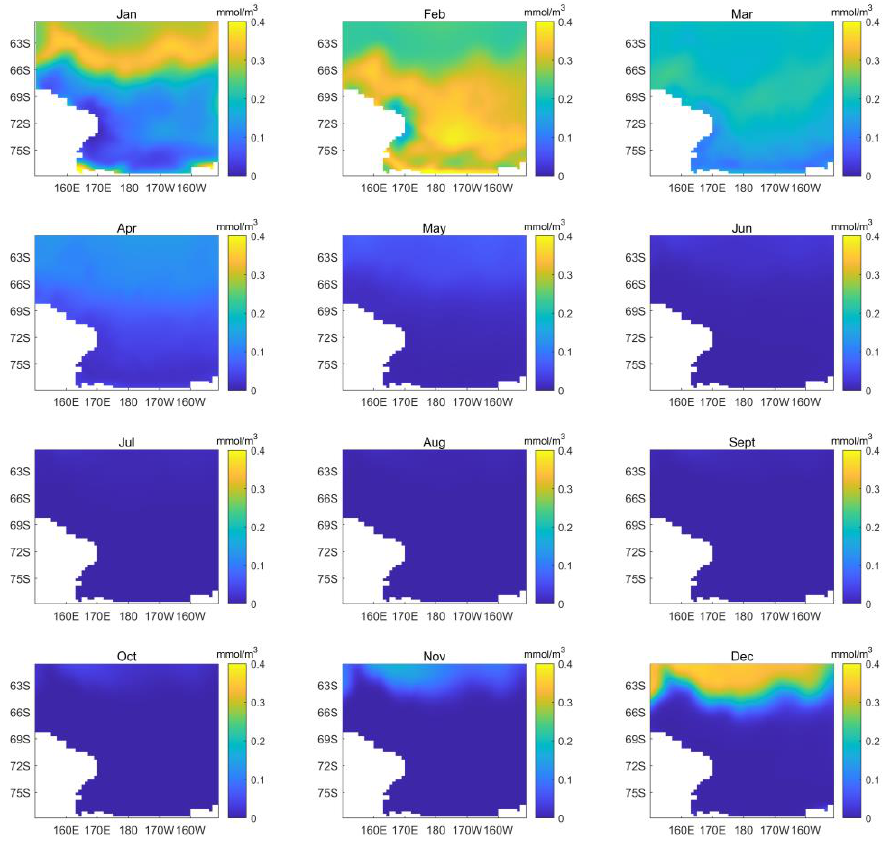
Figure 4. Map of monthly average phytoplankton biomass (mmol/m 3 ) in the Ross Sea region from 1958 to 2018.